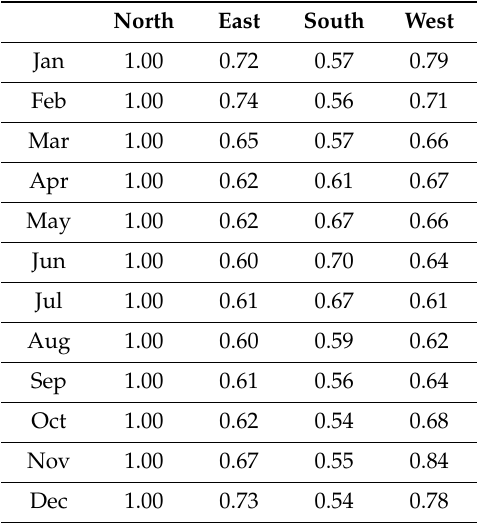
Table 3. Solar gain reduction factors set for the investigated building, as a function of the exposure and for the month, used to manage solar shading devices during simulations (diurnal